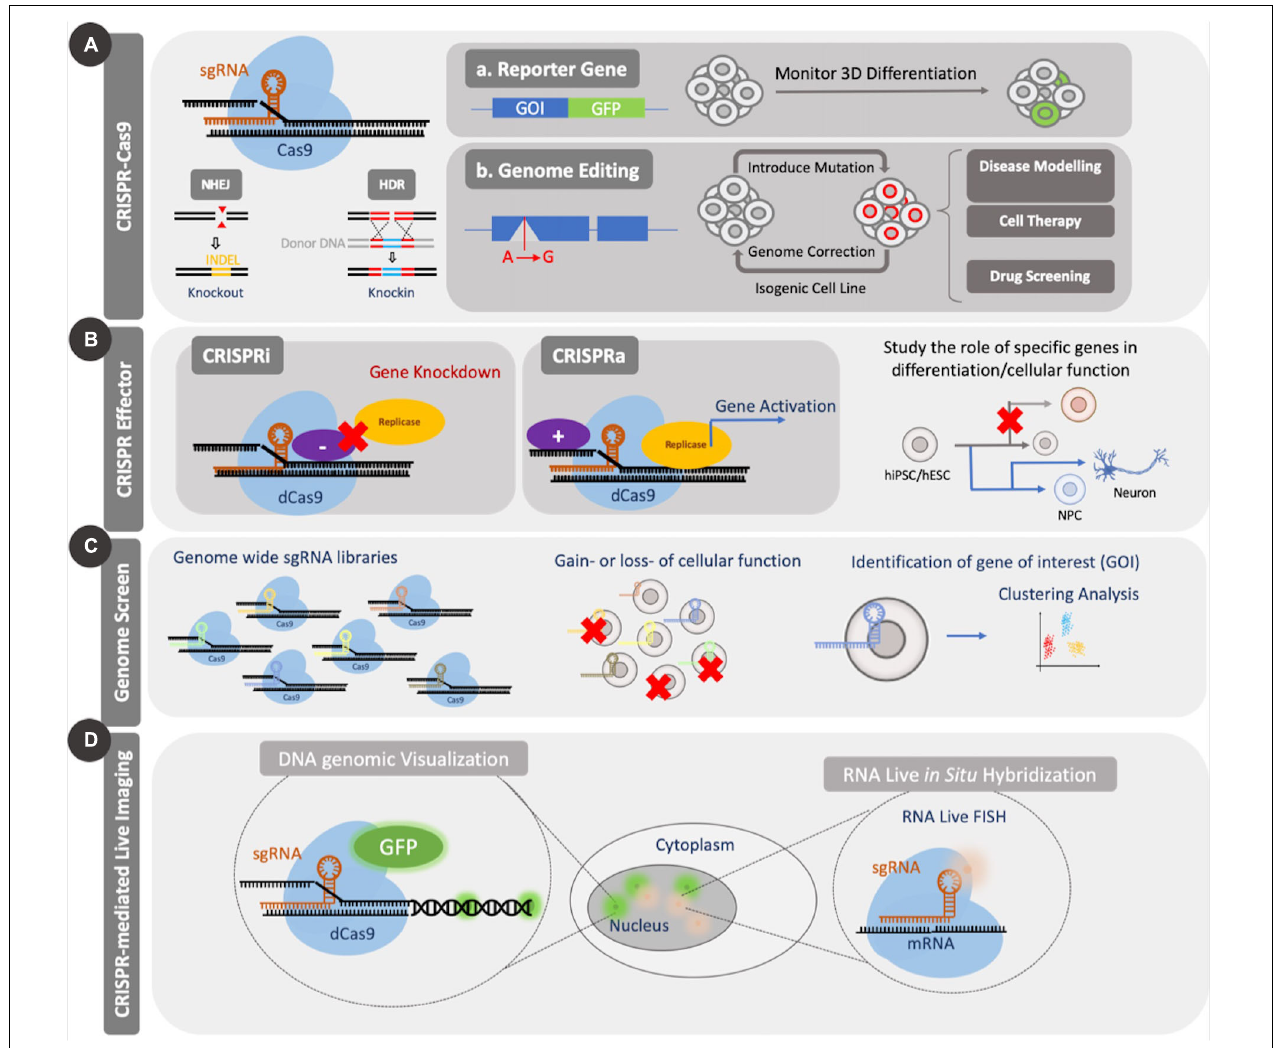
FIGURE 2 | Applications of CRISPR Cas9. CRISPR Cas9 can be used to introduce genetic mutations by causing a double strand break (DSB). The nuclease-null version, dCas9, can be coupled to effector domains to activate or repress gene expression or can be coupled to fluorescent proteins for imaging of genomic elements. CRISPR Cas9 knockout and effector tools have been used for screening applications. (A) Standard CRISPR Cas9 genome editing through introduction of mutations can be used to study the role of several genes during differentiation or to create disease models for enhanced mechanistic understanding or drug screening. (B) Application of dCas9 to genomic regulation in the form of CRISPRi/a can be used to study both differentiation and cellular function. (C) Large scale genomic screens using CRISPR Cas9/dCas9 can be used to identify essential genes for several cellular processes through gain or loss of function studies. Such screens enable identification of candidate genes from a pool for further investigation. (D) Coupling dCas9 to fluorescent domains, like GFP, enable facile visualization of specific regions of the genome and temporal